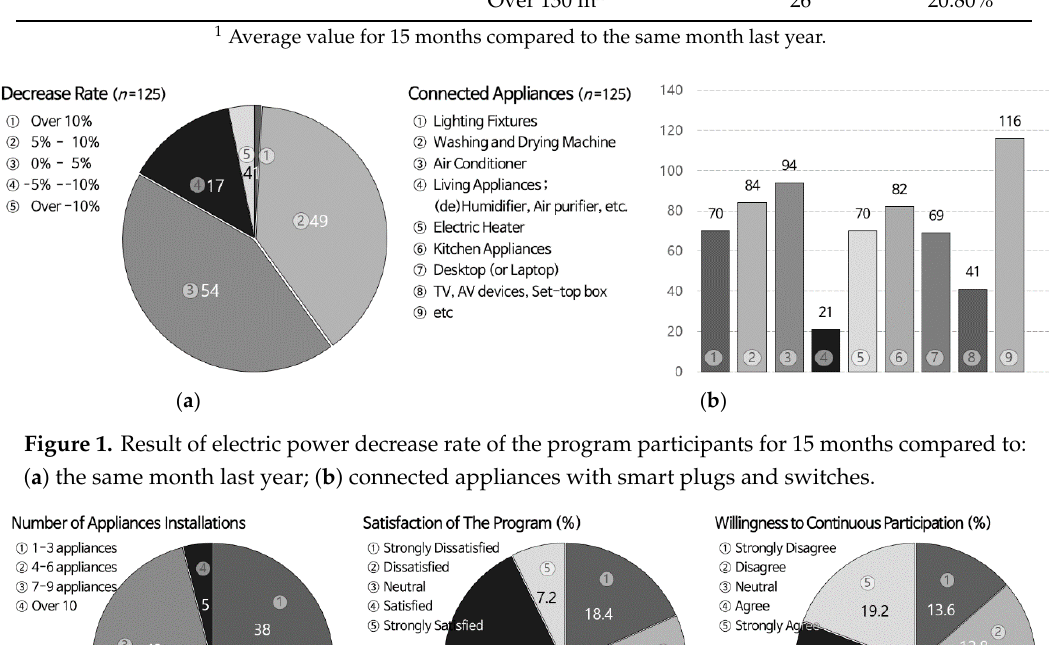
Figure 2. Results: ( a ) Number of installed smart plugs and switches; ( b ) satisfaction with the program; and ( c ) willingness to continue to participate. 3.2. Effects of Home Energy Savings by The Program A paired-samples t -test was conducted to verify the quantitative difference between the amount of power reduction and the year-on-year reduction in power usage, measured over the 15 months experiment (see Table 4); the t-value came to 10.666, meaning that the reduced amount of power usage before and after this program shows a statistically significant difference. Moreover, given that the average power consumption of apartment complexes where program participants reside increased by about 1.69% year-on-year, participants in this program reduced power usage through relevant devices and training.